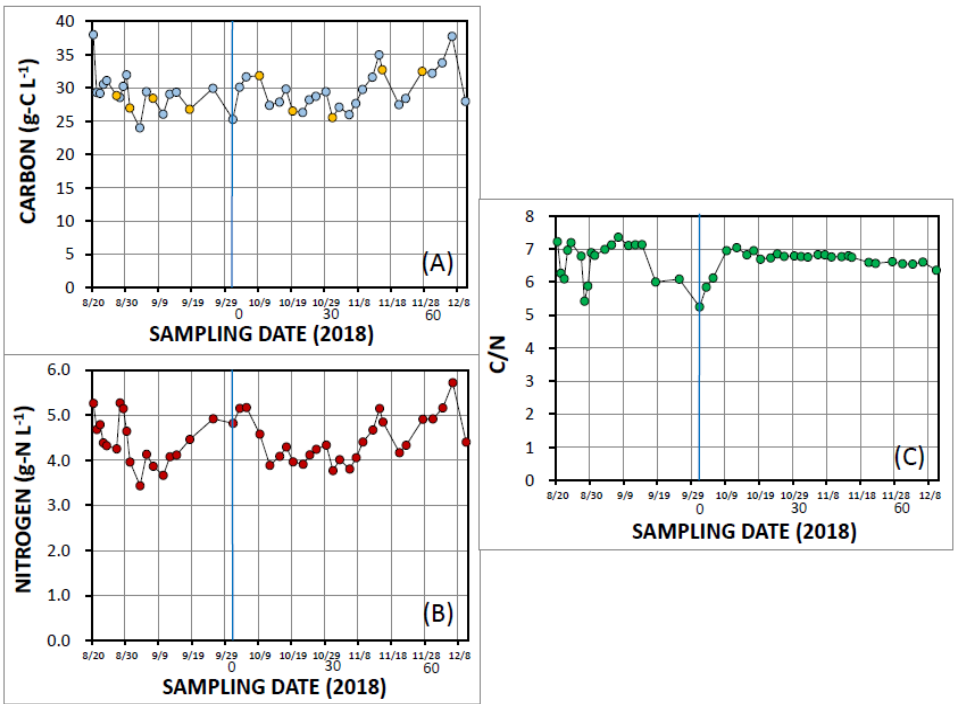
Figure 4. Changes in the concentrations of organic carbon ( A ), organic nitrogen ( B ), and the carbon: nitrogen ratio (C/N) ( C ) in the soluble-type cutting fluid (S-CF). Occasions of supplying tap water are shown by orange circles ( A ). Blue vertical lines show the day when bubbling with microbubbles was initiated (1 October). Numbers of 0, 30, and 60 below the date in each figure show days after starting to supply microbubbles.